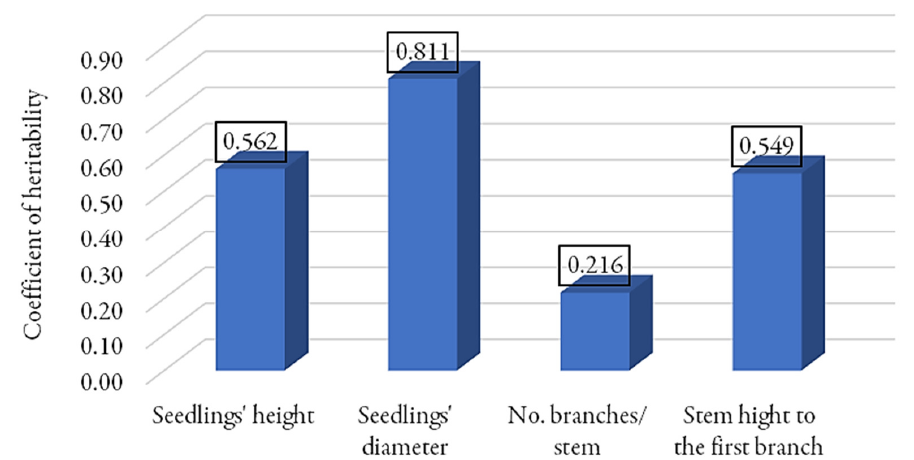
Figure 9. Broad-sense heritability (H 2 ) for the traits of R. pseudoacacia seedlings grown in the field, at